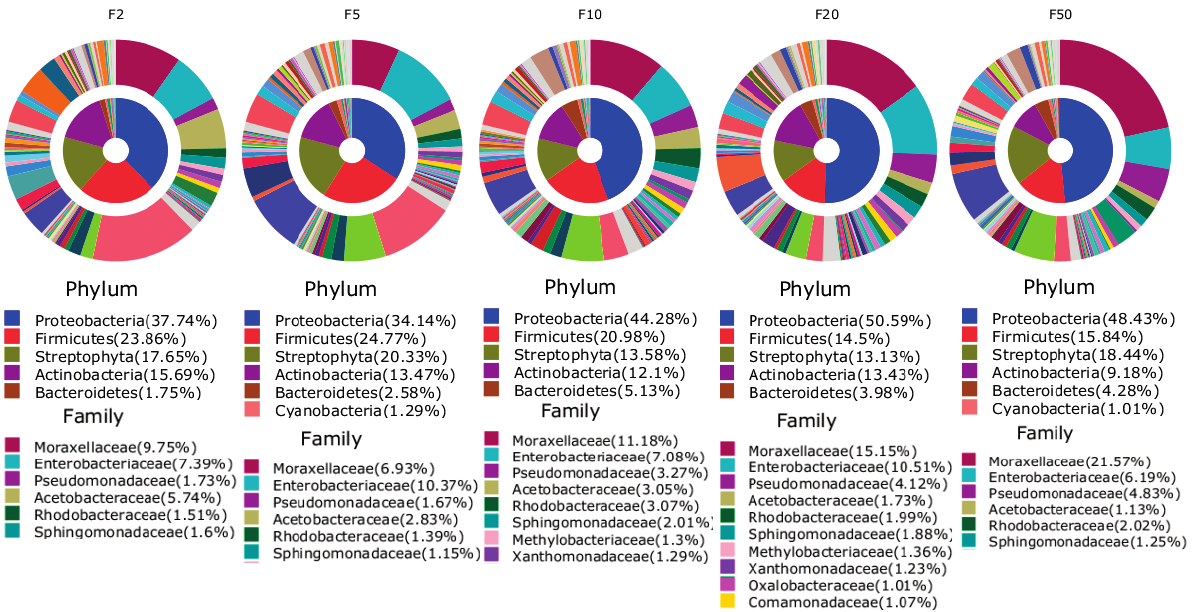
Figure 2. Average composition of bacteria from all samples (inner area: Phylum, outer area: Family). Phyla and Families with more than 1% of their proportion were represented.